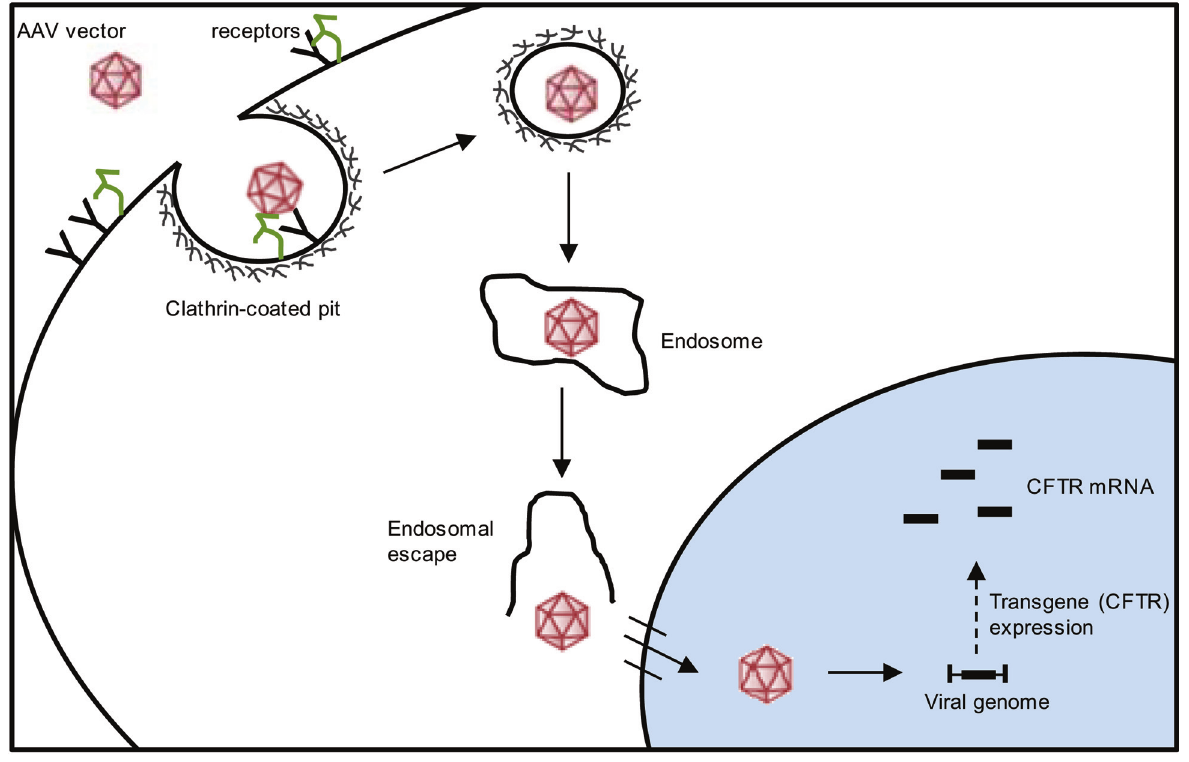
Figure 2. Cell entry and trafficking of the adeno-associated virus (AAV) vector. The AAV vector enters the cell by endocytosis in a receptor-mediated manner, through clathrin-coated pits. After endocytosis, the AAV vector should escape from the endosome, enter the nucleus through the nuclear pore complex and promote transgene expression (cystic fibrosis transmembrane conductance regula- tor,